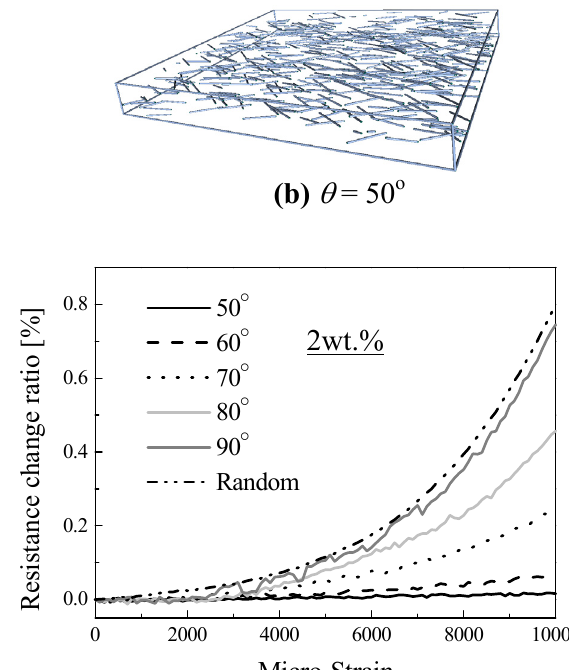
Figure 23. CNT alignment models and sensor